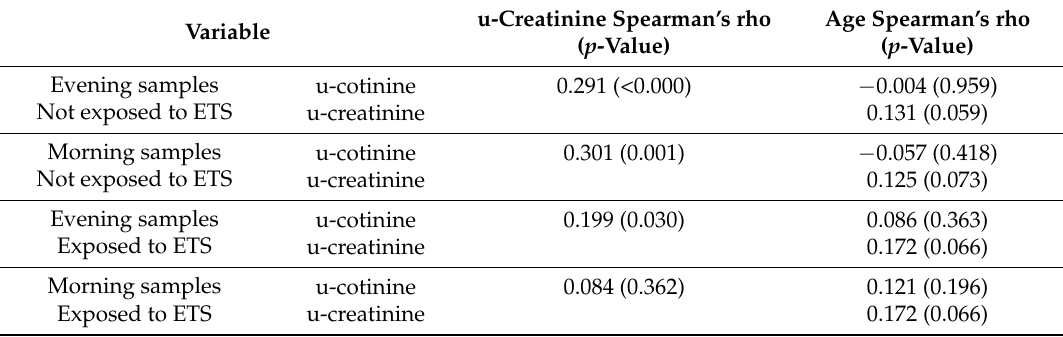
Figure 1. Reference values of urinary cotinine levels (expressed both as µ g L − 1 and µ g g − 1 creatinine) for children not exposed and exposed to Environmental Tobacco Smoke (ETS) calculated for all participants and according to gender: ( a ) urinary cotinine levels expressed both as µ g L − 1 ; ( b ) urinary cotinine levels expressed both as µ g g − 1 creatinine. Table 4. Spearman’s rho among u-cotinine levels ( µ g L − 1 ), u-creatinine (g L − 1 ) and age separately for evening and morning samples and for ETS